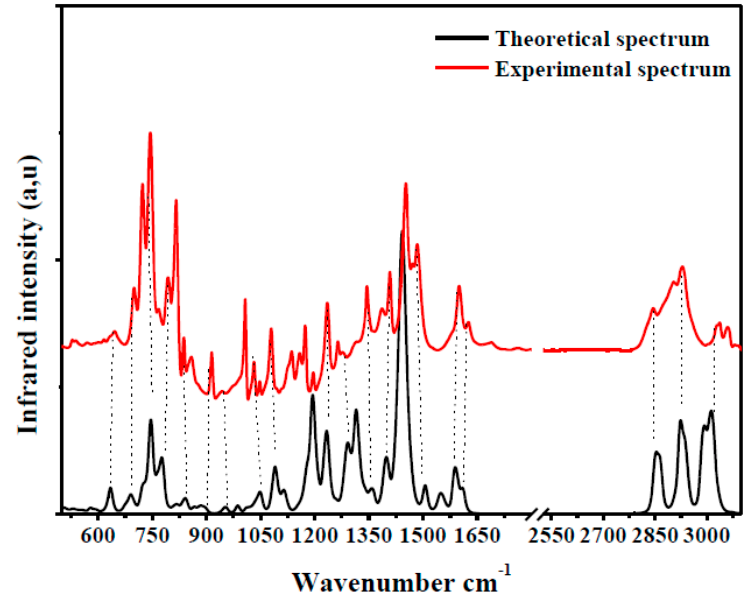
Figure 3. Optimized model structure of the PVK-F8T2.